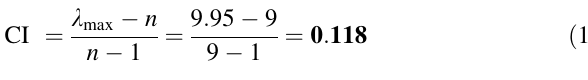
n = number of alternatives, PI groups in this case.